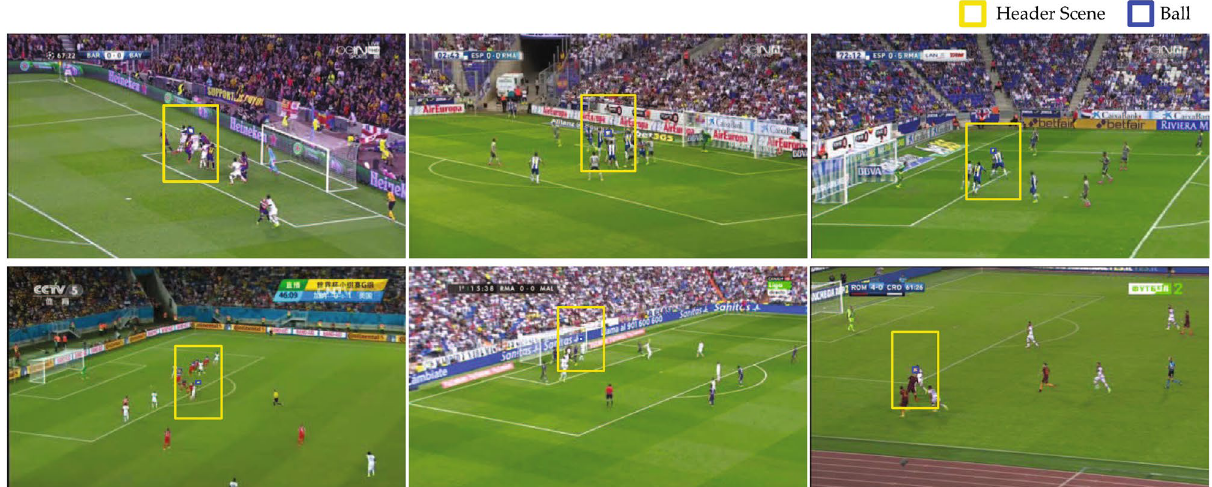
Figure 4. Examples of unsuccessful header detection. Unidentified header events included crowded header scenes (e.g. header after a corner kick) as well as events with the ball being distant from the camera. In these cases, the ball could not be detected in most video frames and thus could not be tracked.